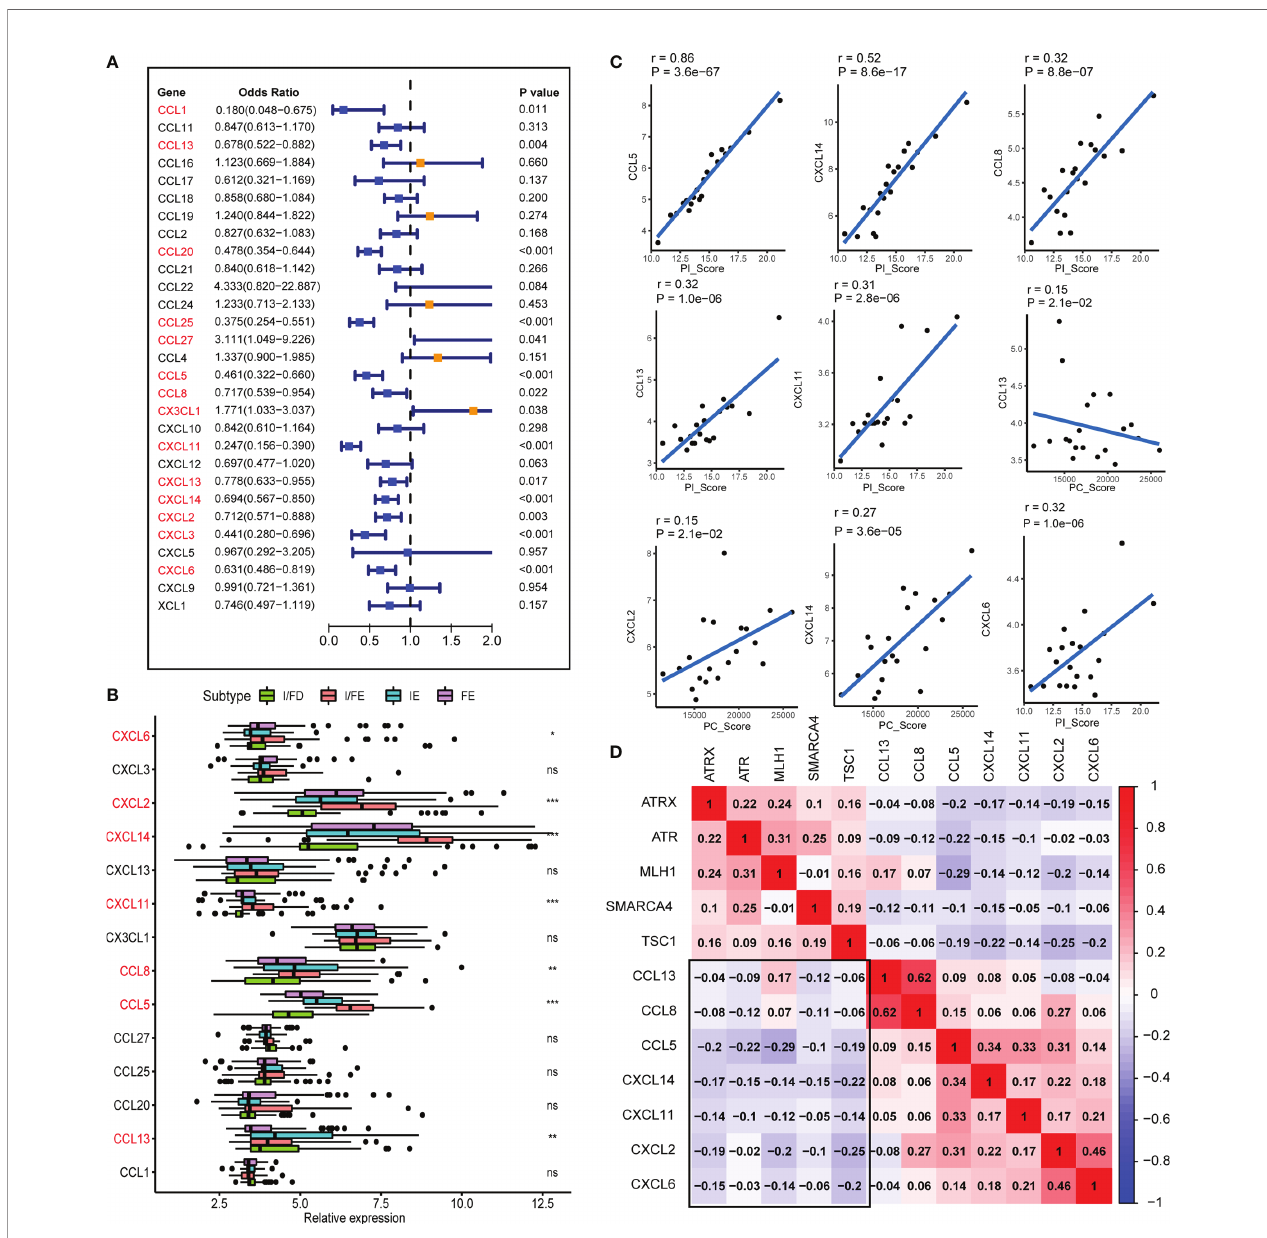
FIGURE 6 | The chemokines associated with the four subtypes and PI_Score/PC_Score. (A) The univariate logistic regression analysis of 29 common expressed chemokines. (B) Differential expression of the 14 chemokines in normal and GEP-NEN tissues. (C) Pearson ’ s correlation analysis was used to assess the relationships between the PI_Score/PC_Score and the 7 key chemokines. (D) Hierarchical clustering analysis was performed using Pearson ’ s correlation coef fi cient between the 7 key chemokines and fi ve-pathway-related molecules. P values <0.05 were considered signi fi cant (ns, P > 0.05; *, P < 0.05; **, P < 0.005; ***, P <